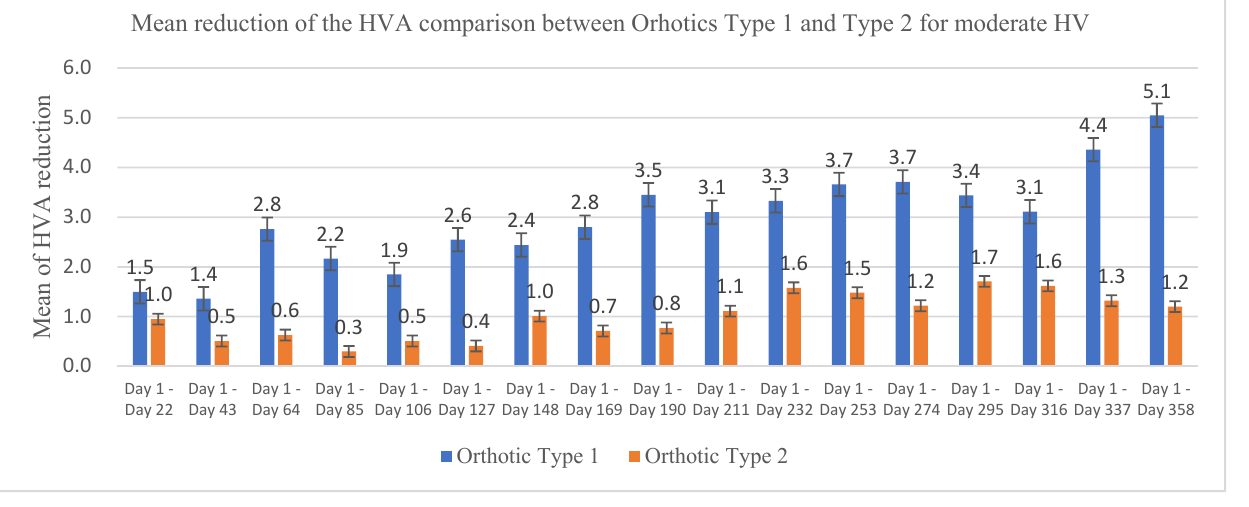
Figure 4. Mean of HVA reduction comparison between Orthotics Type 1 and Type 2 for moderate HV.